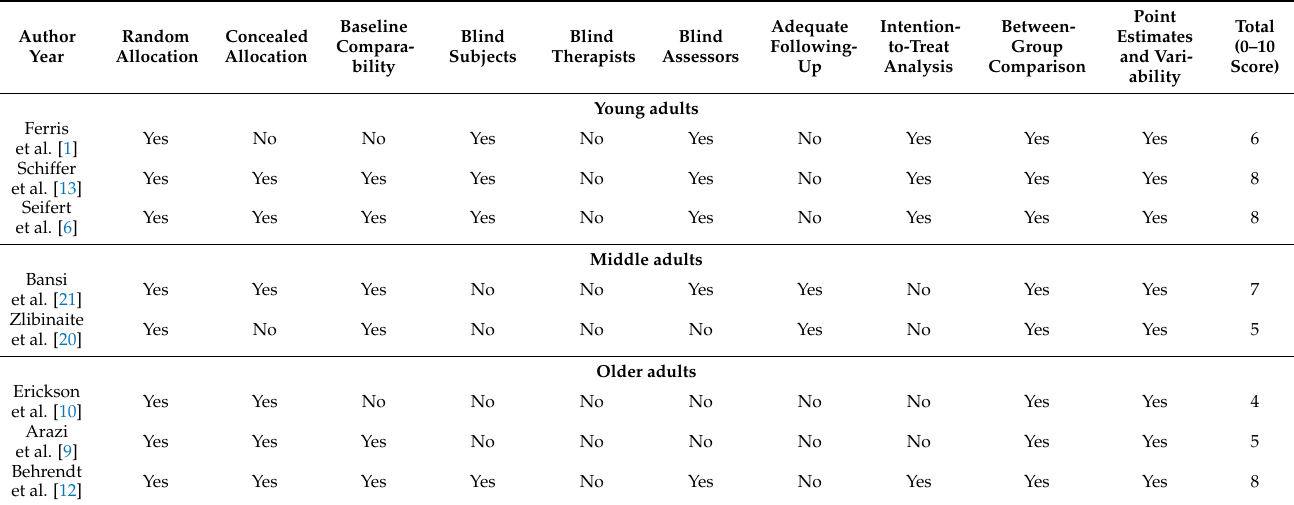
Figure 2. The evaluation of potential biases for included studies. Table 2. Methodological quality of studies included systematic